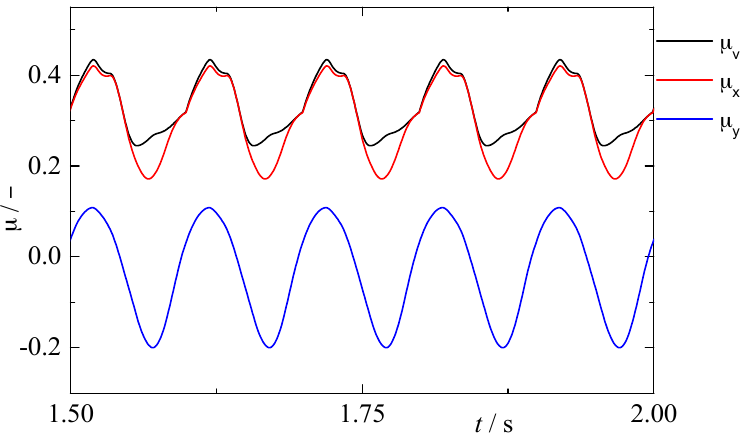
Figure 11 . The change of frictional coefficient calculated by modified model ( (cid:2016) = Figure 11. The change of frictional coefficient calculated by modified model ( θ = π h = 2 µ m and f nk = 0.83, ω = 62.8 ( rad )) = 0.83 , (cid:2033) = 62.8 (rad) ). ℎ = 2 μm and (cid:1858) (cid:3041)(cid:3038)